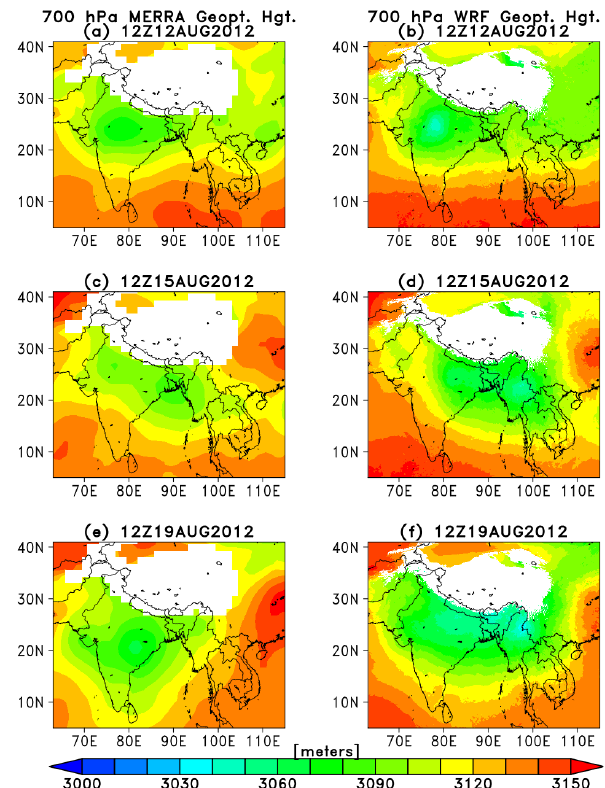
Fig. 4. MERRA (left column) and WRF (right column) geopo- tential height (m) at 700hPa for 12:00UTC 12 August ( a and b ), 12:00UTC 15 August ( c and d ), and 12:00UTC 19 Au- gust ( e and f